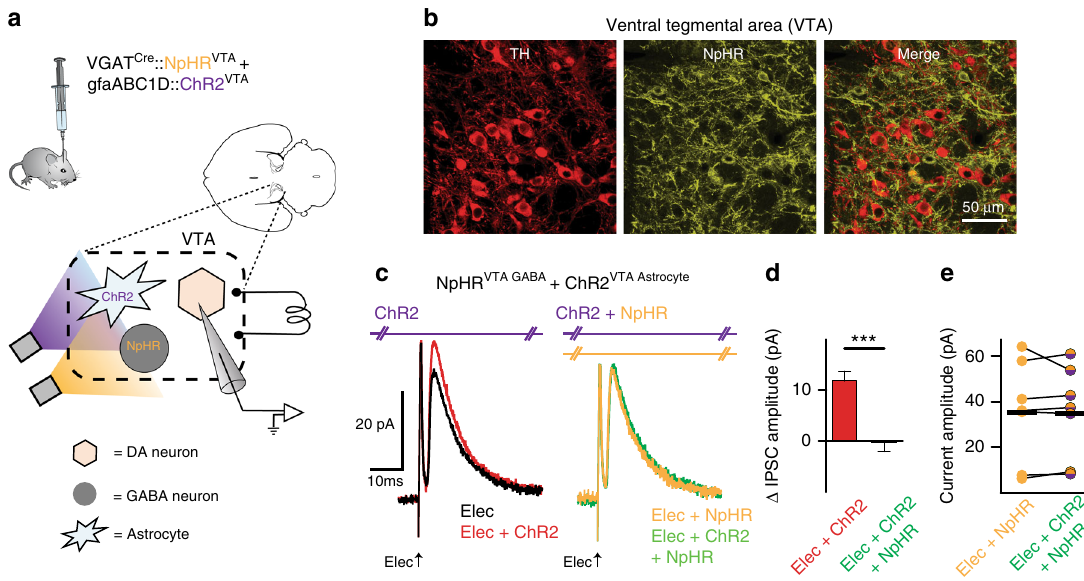
Fig. 5 Astrocyte-dependent increase in dopamine neuron inhibition is mediated by VTA GABA neurons. a Experimental manipulation. b Immunocytochemistry demonstrating TH positive cells (red) and eNpHR expression (yellow). On the right are the two images merged together. c Voltage- clamp traces (V h = + 10 mV) from a VTA dopamine neuron. ChR2 stimulation during electrical stimulation (Elec + ChR2, red trace; ChR2 stimulated at 405 nm to minimize activation of eNpHR) increases the IPSC amplitude relative to electrical stimulation alone (Elec, black trace). When ChR2 on astrocytes is activated concurrently with eNpHR activation on GABA neurons during electrical stimulation (Elec + ChR2 + eNpHR, green trace) the increase in IPSC amplitude was eliminated. Electrical stimulation with GABA neuron hyperpolarization alone (Elec + eNpHR, yellow trace) has no difference relative to electrical stimulation along with ChR2 on astrocytes and eNpHR activation on GABA neurons (Elec + ChR2 + eNpHR, green trace). d The increase in IPSC amplitude when ChR2 was photoactivated with electrical stimulation (Elec + ChR2, red) was blocked when GABA neurons were simultaneously hyperpolarized (Elec + eNpHR + ChR2, green). e IPSC amplitudes during electrical stimulation with GABA neuron hyperpolarization (Elec + eNpHR, yellow) were not changed when ChR2 stimulation was added (Elec + eNpHR + ChR2, purple-yellow; paired t -test t (6) = 0.1247, P = 0.90, n = 7 cells, 4 mice). *** P < 0.001; Error bars indicate ±